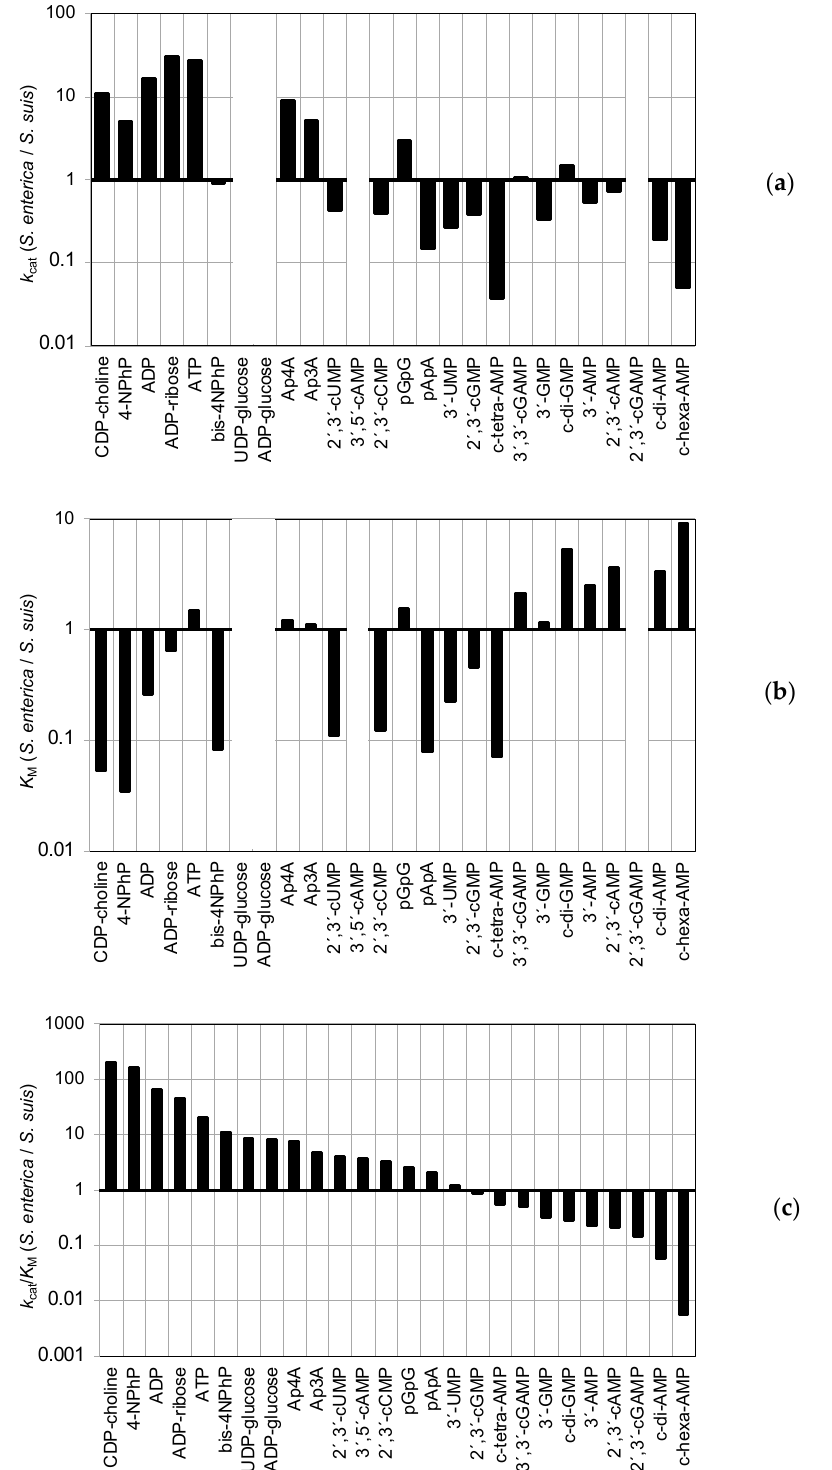
Figure 1. Comparison of kinetic parameters of S. enterica CpdB versus S. suis SntA for different substrates. S. enterica data are taken from Table 1, while those for S. suis were from previous work [10], except for c-tetra-AMP and c-hexa-AMP (Table 1). The bars represent parameter ratios in logarithmic scale: ( a ) ratios of k cat values; ( b ) ratios of K M values; ( c ) ratios of k cat /K M values. Blank columns in panels ( a , b ) indicate absence of the corresponding parameter ( k cat or K M ) for S. enterica and/or S. suis SntA. In the three panels, the substrates are ordered from higher to lower ratios of catalytic efficiency ( k cat /K M ).